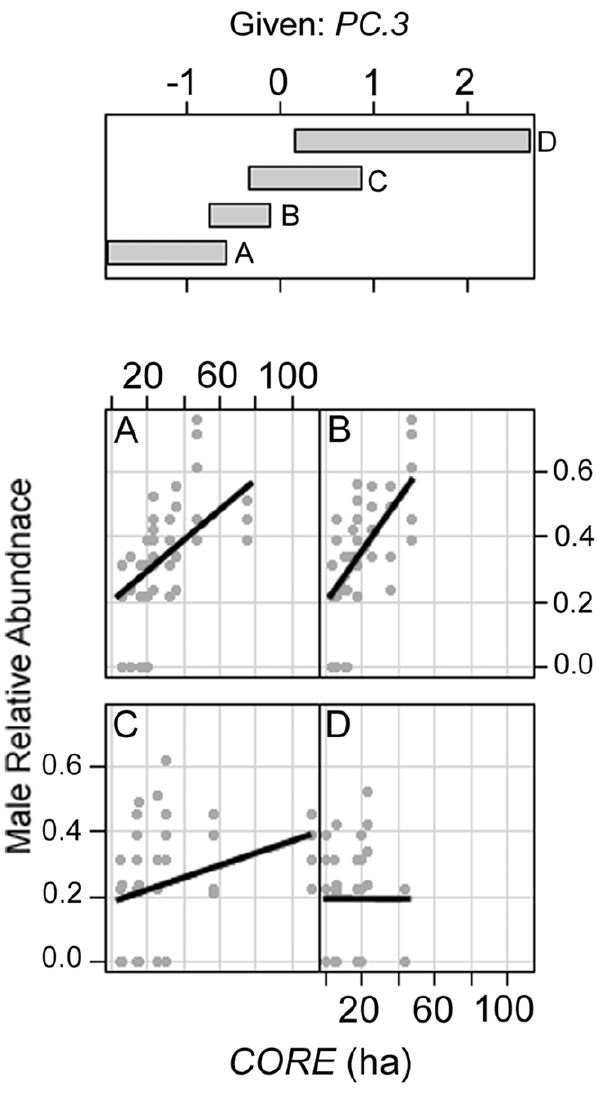
Figure 1. Conditioning plot of CORE (ha) given PC.3 for male relative abundance. The top box shows regions of PC.3 for which relative abundance is plotted against CORE . The overlap in PC.3 is 25%. Conditioning plots show the range of a response variable (here, male relative abundance) for values of one explanatory variable (here, fragment core area, CORE ) over given ranges of a second explanatory